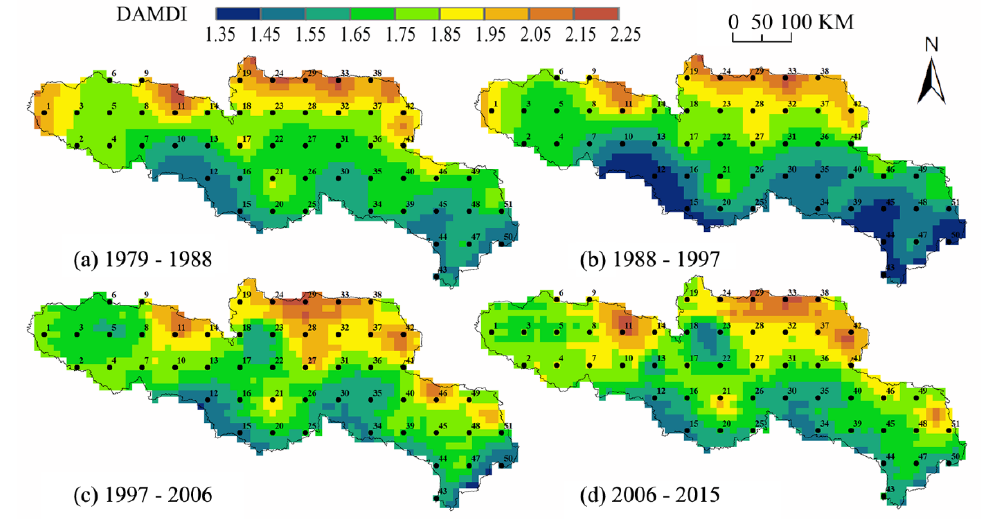
Figure 10. Decadal average intra-annual variability for daily precipitation series and its trends measured by decadal averaged annual marginal disorder index (DAMDI) and U MK respectively, for ( a )